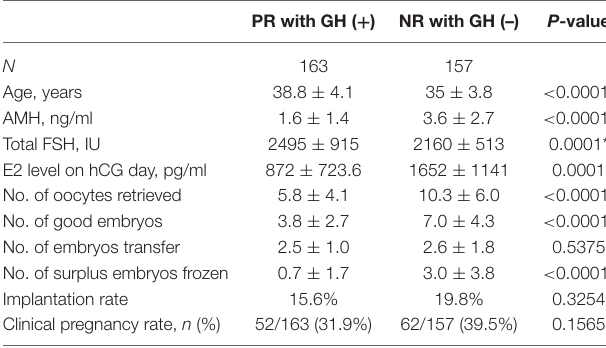
TABLE 3 | Subgroup analysis of the pregnancy outcome for poor-responders. Variable